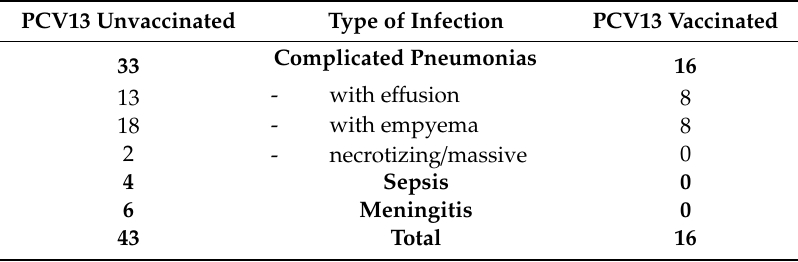
Table 3. Number of cases grouped for infection type in children under 8 years of age with serotype 3 Streptococcus pneumoniae invasive pneumococcal infections and known vaccine status. PCV13 vaccinated children were all born after 2011, while the PCV13 unvaccinated children group was derived from grouping together children born before 2011 plus those born in PCV13 that had not completed their age-appropriate vaccination series at the moment of sample collection. Clinical subgroups are shown below the main groups that are presented in bold. PCV13 Unvaccinated Type of Infection PCV13 Vaccinated 33 Complicated Pneumonias - with e ff usion - with empyema - necrotizing /